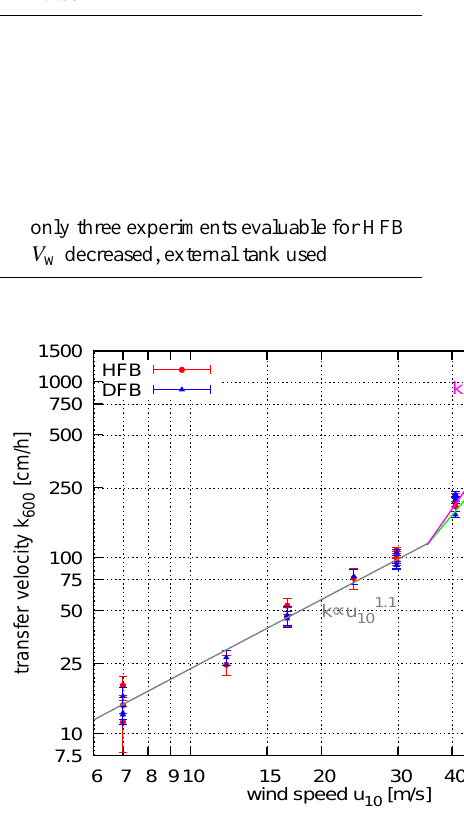
with x depending on 10